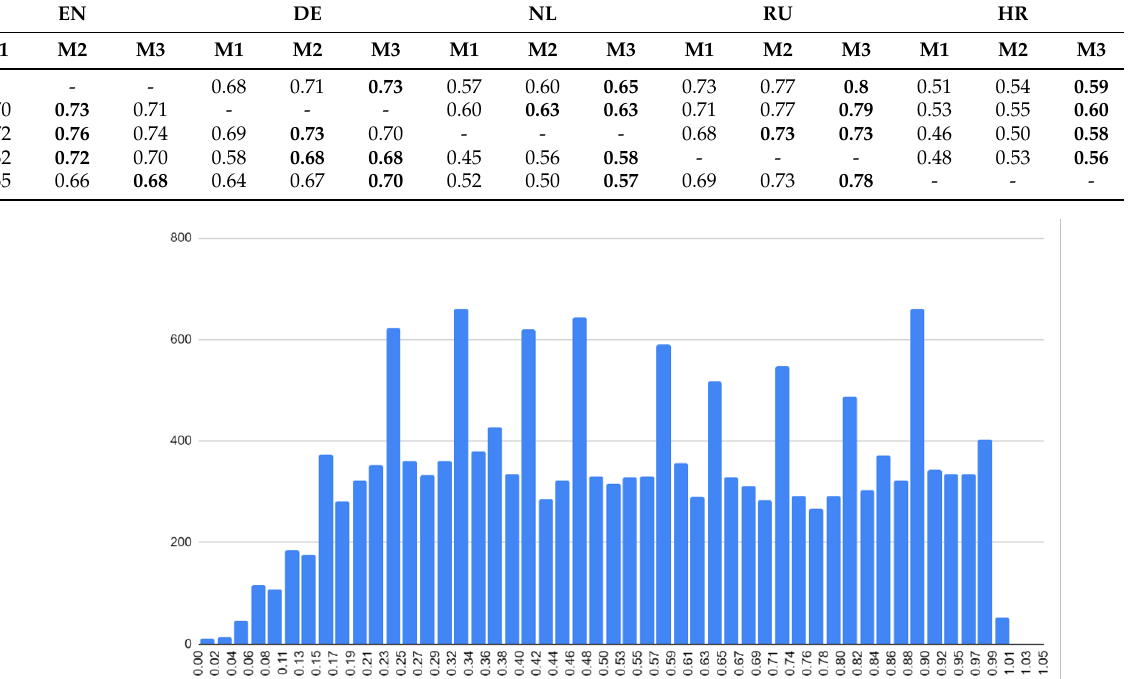
Figure 2. Histogram of concreteness ratings from Dutch